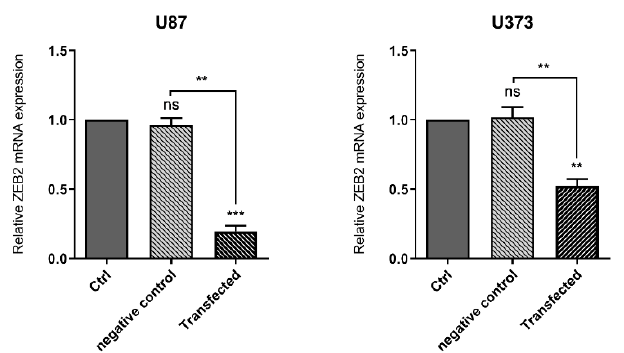
Figure 1. ZEB2-siRNA significantly downregulated ZEB2 in both U87 and U373 cell lines. The results are expressed in comparison to the negative control (transfected with non-target siRNA) and non-transfected groups (control group). The results are shown as mean (M) ± SD (** p < 0.01, *** p < 0.001).